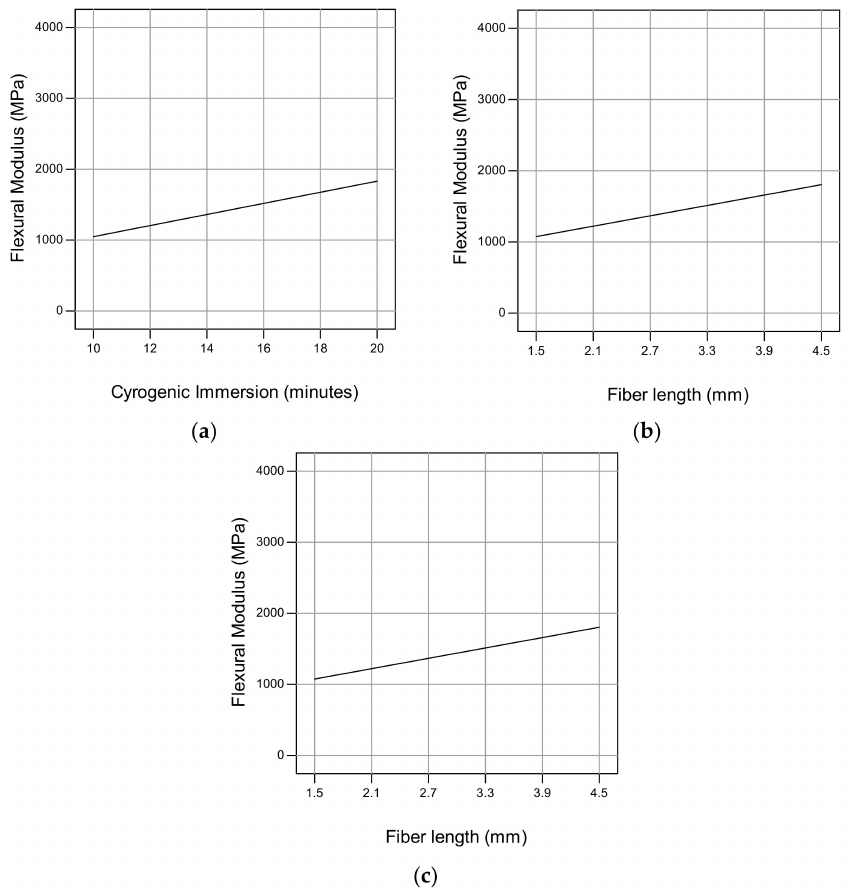
Figure 4. Effect of the individual factors on flexural modulus: ( a ) effect of cryogenic treatment; ( b ) effect of fiber length; ( c ) effect of fiber